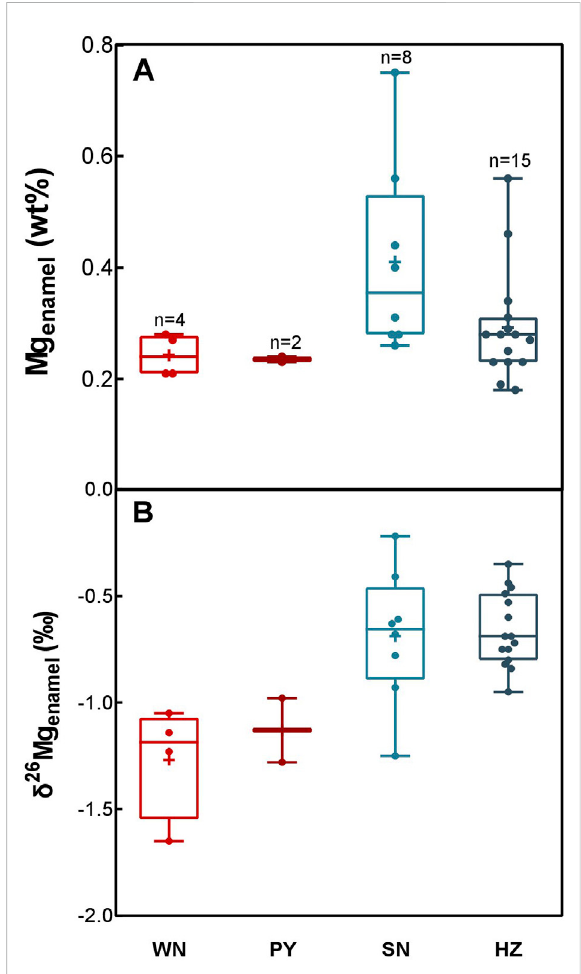
FIGURE 3 Magnesium content (A) and δ 26 Mg values (B) in modern human teeth enamel from different regions. “ + ” represent the averagevalue.Theboxesrangebetweenmintomaxandshowthe median